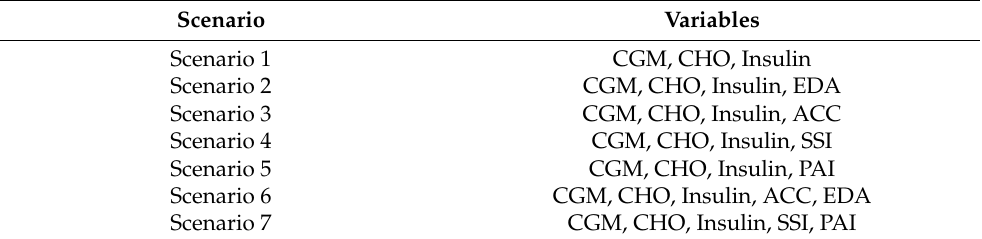
Table 1. Scenarios considered in our ablation study to understand the contribution of different variables on BG prediction